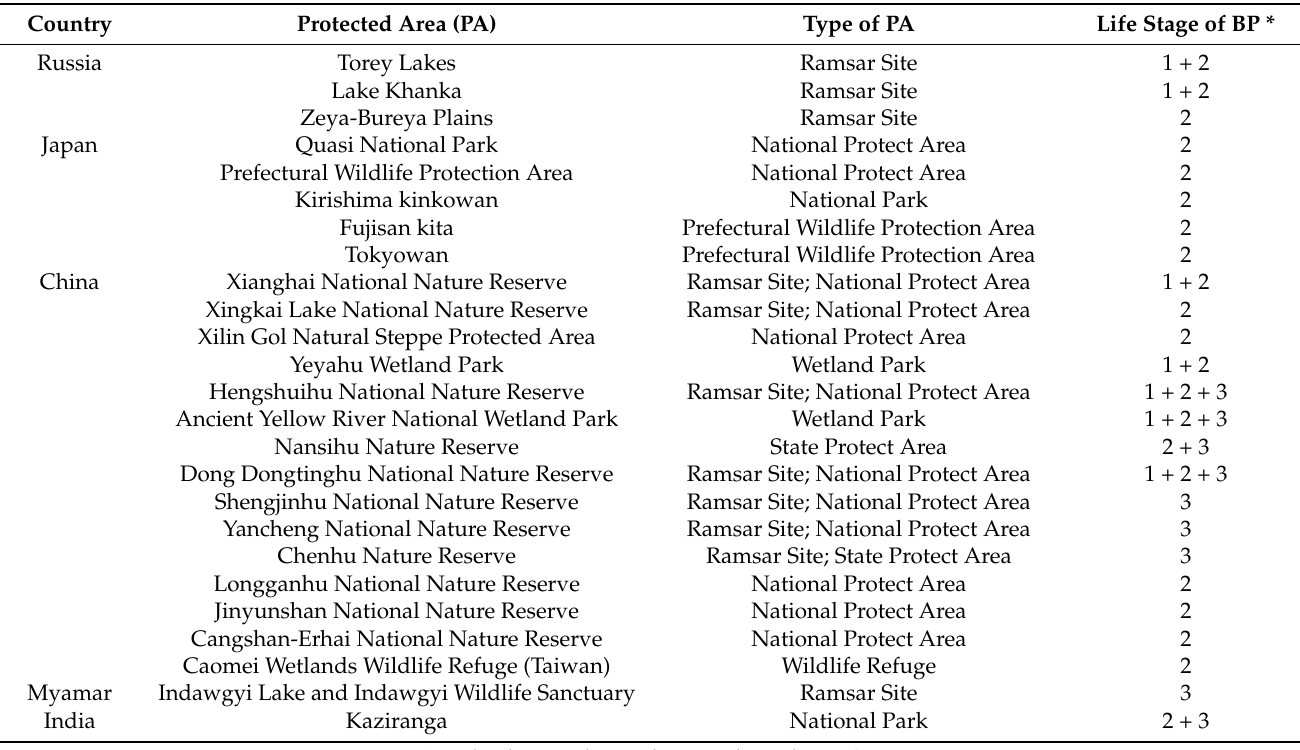
Table 2. Current Baer’s Pochard present sites in Protect Area.